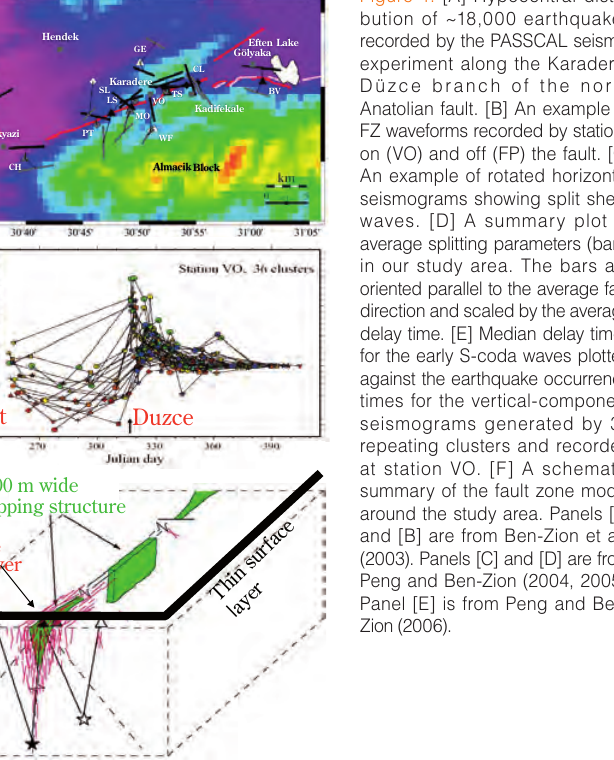
Figure 1. [A] Hypocentral distri- bution of ~18,000 earthquakes recorded by the PASSCAL seismic experiment along the Karadere- Düzce branch of the north Anatolian fault. [B] An example of FZ waveforms recorded by stations on (VO) and off (FP) the fault. [C] An example of rotated horizontal seismograms showing split shear waves. [D] A summary plot of average splitting parameters (bars) in our study area. The bars are oriented parallel to the average fast direction and scaled by the average delay time. [E] Median delay times for the early S-coda waves plotted against the earthquake occurrence times for the vertical-component seismograms generated by 36 repeating clusters and recorded at station VO. [F] A schematic summary of the fault zone model around the study area. Panels [A] and [B] are from Ben-Zion et al., (2003). Panels [C] and [D] are from Peng and Ben-Zion (2004, 2005). Panel [E] is from Peng and Ben- Zion